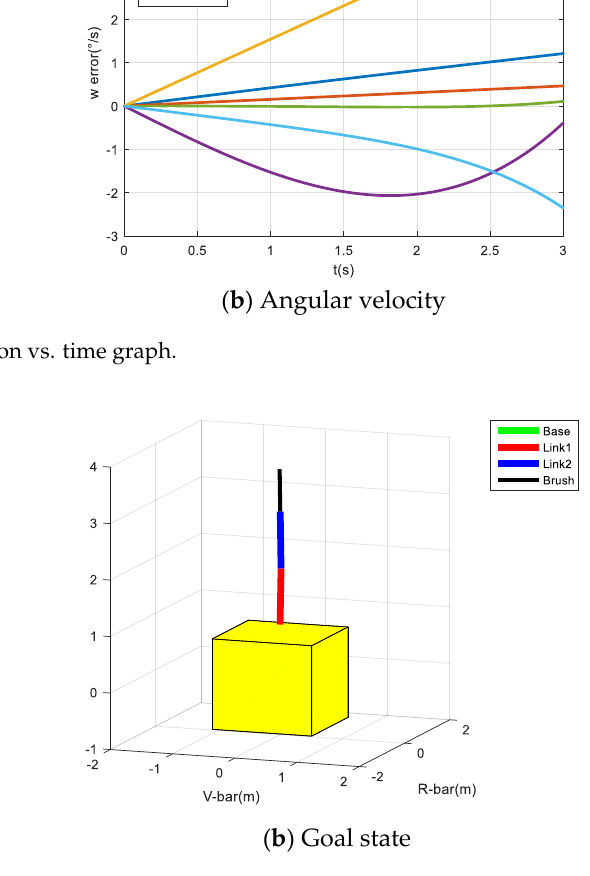
Figure 10. Schematic diagrams of initial and goal states.